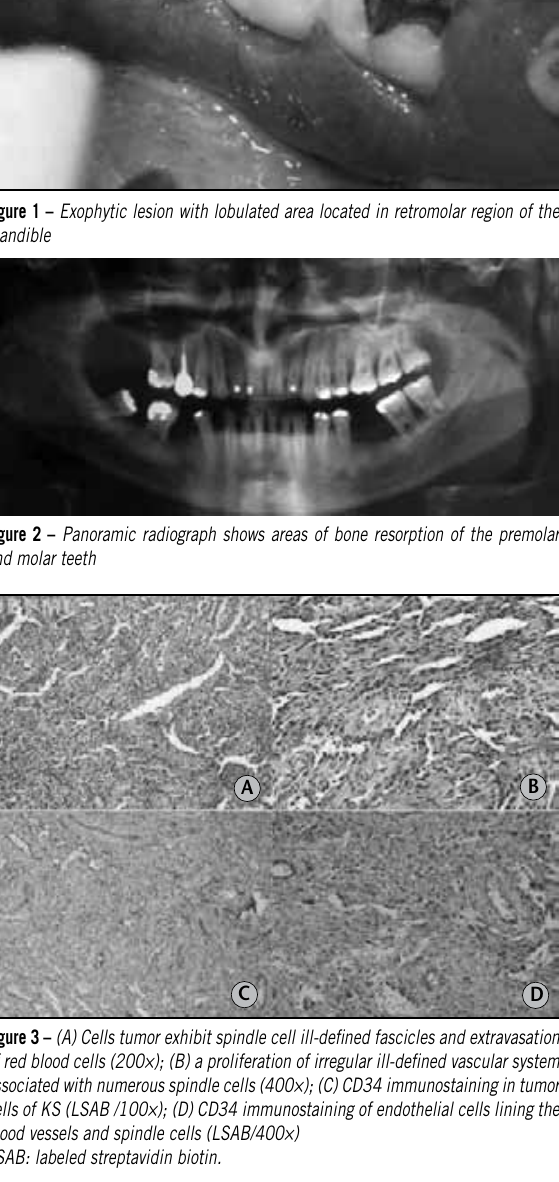
C Figure 3 – (A) Cells tumor exhibit spindle cell ill-defined fascicles and extravasation of red blood cells (200×); (B) a proliferation of irregular ill-defined vascular system associated with numerous spindle cells (400×); (C) CD34 immunostaining in tumor cells of KS (LSAB /100×); (D) CD34 immunostaining of endothelial cells lining the blood vessels and spindle cells (LSAB/400×) LSAB: labeled streptavidin biotin.